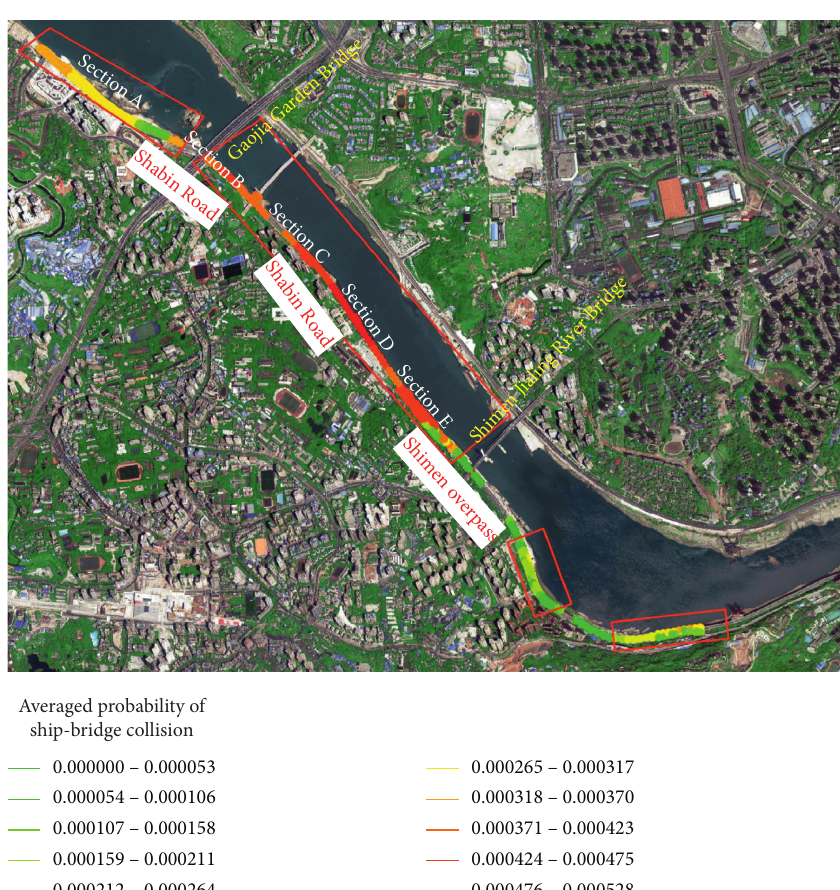
Figure 13: Averaged probability of ship-pier collision in the study